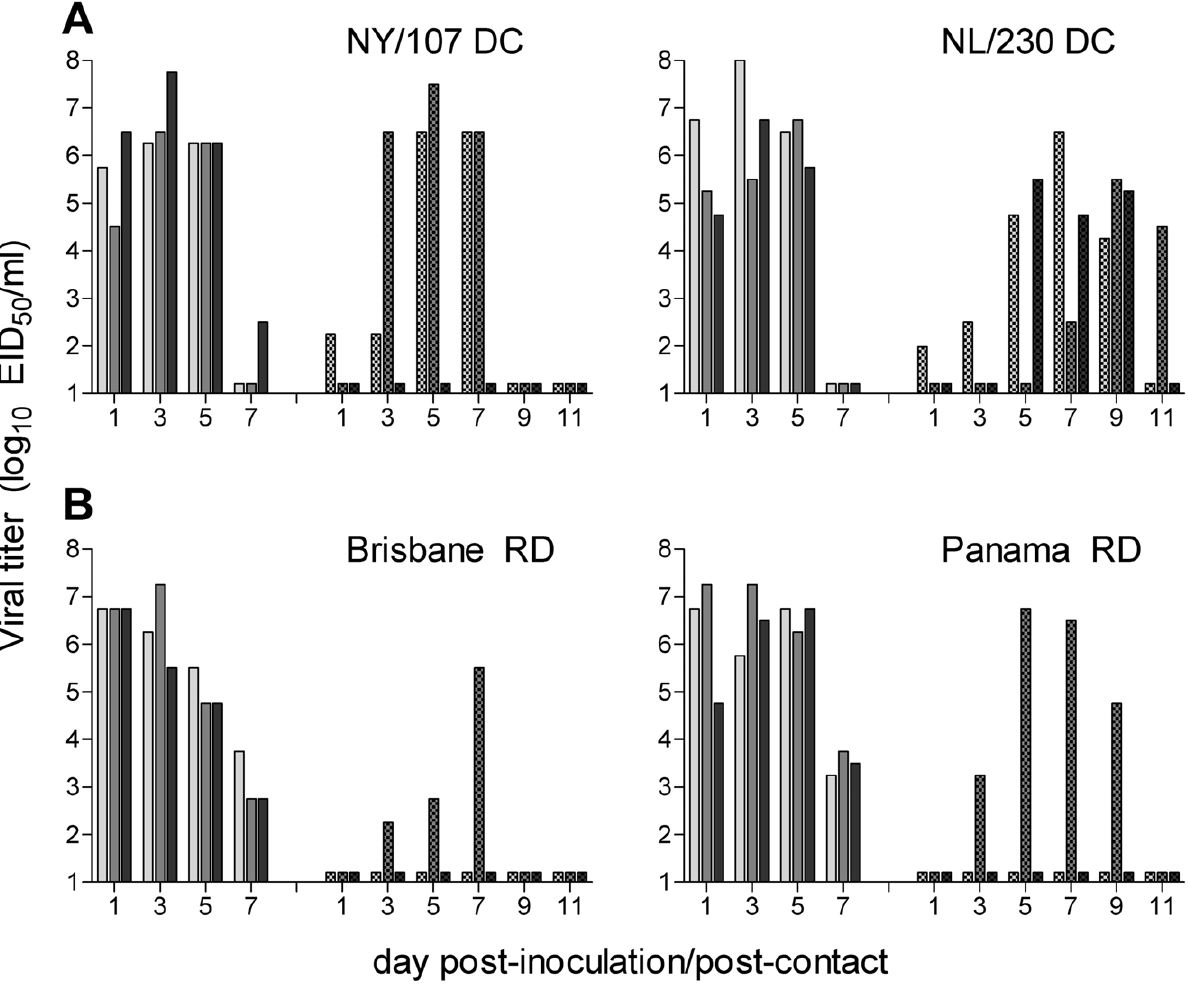
Figure 5. Transmissibility of influenza viruses in ferrets following ocular inoculation. Three ferrets were inoculated by the ocular route with 10 6 EID 50 of NY/107, NL/230, Brisbane or Panama virus, and nasal washes were collected from each ferret on the indicated day p.i. (solid bars). A naı¨ve ferret was placed either in the same cage (A) or in an adjacent cage with perforated side walls (B) as each inoculated ferret 24 hrs p.i., and nasal washes were collected from each contact ferret on indicated days p.c. (hatched bars) to assess virus transmission in the presence of direct contact or respiratory droplets, respectively. The limit of virus detection was 10 1.5 EID 50 /ml.